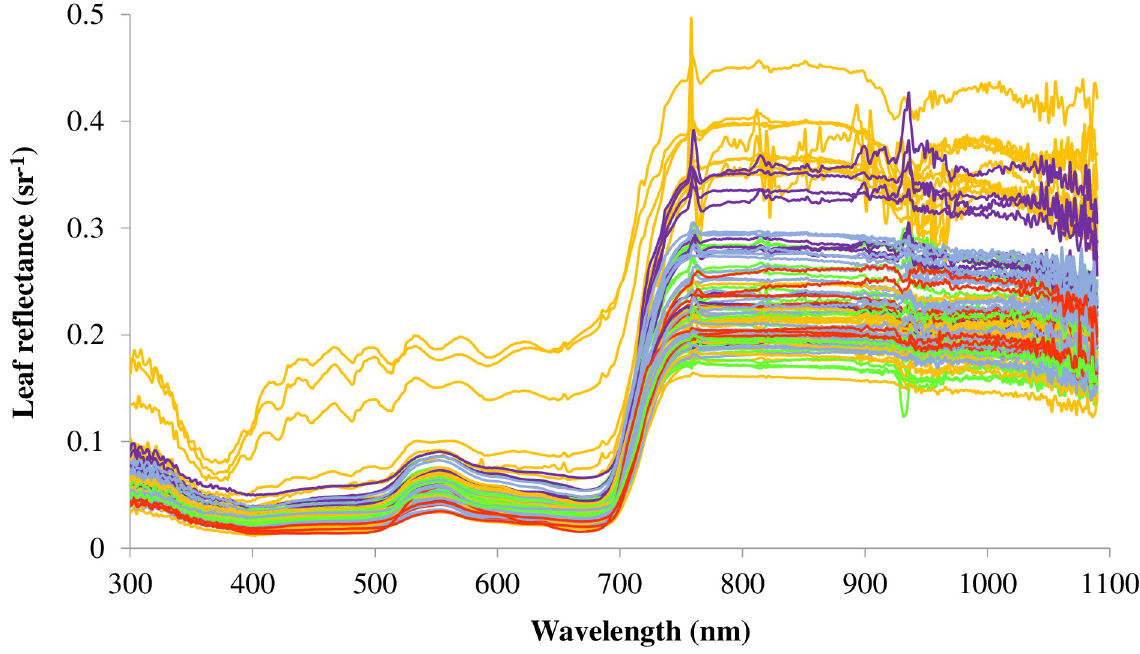
Fig 2. Leaf reflectance curves of five different Populus taxa. D × T and T × D taxa were combined and shown as D × T, and taxa (D × N) × M was included in D × N (S1 Table). D × D = P . deltoides × P . deltoides , D × M = P . deltoides × P . maximowiczii , D × N = P . deltoides × P . nigra , (D × N) × M = P . deltoides × P . nigra × P . maximowiczii , D × T = P . deltoides × P . trichocarpa , T × D = P . trichocarpa × P . deltoides , and T × M = P . trichocarpa × P . maximowiczii .